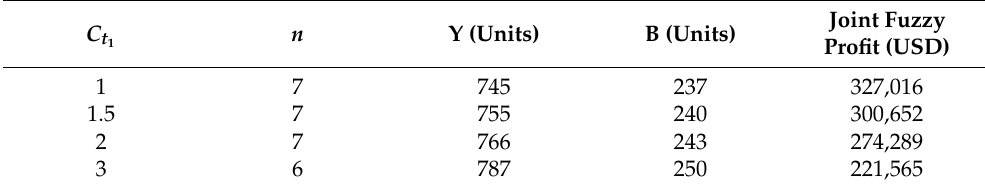
Table 16. Impact of the fixed carbon emission cost due to disposal on the decision variables and joint fuzzy profit.